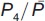
Frequency distribution for P4/P¯
.